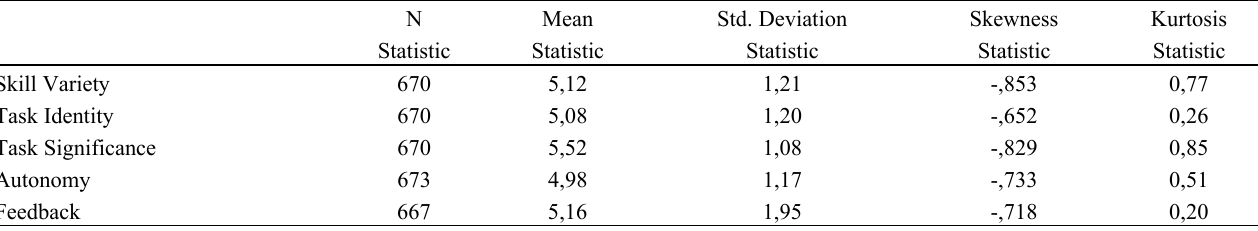
Table 3 : Descriptive statistics for the revised JDS